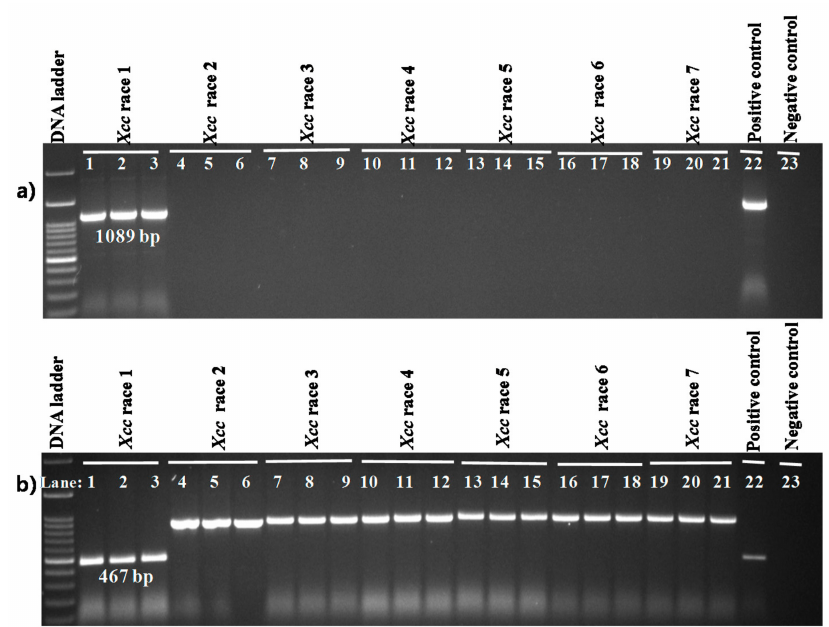
Figure 5. Bio-PCR detection of Xcc race 1 in cabbage leaves using two race 1 specific markers ( a ) Xcc_47R1 and ( b ) Xcc_85R1; Lanes 1–21: Three inoculated leaf samples against each of seven Xcc races (races 1–7); Lane 22: Control HRIW-3811-genomic DNA (race 1) and Lane 23: Negative control (DDW).